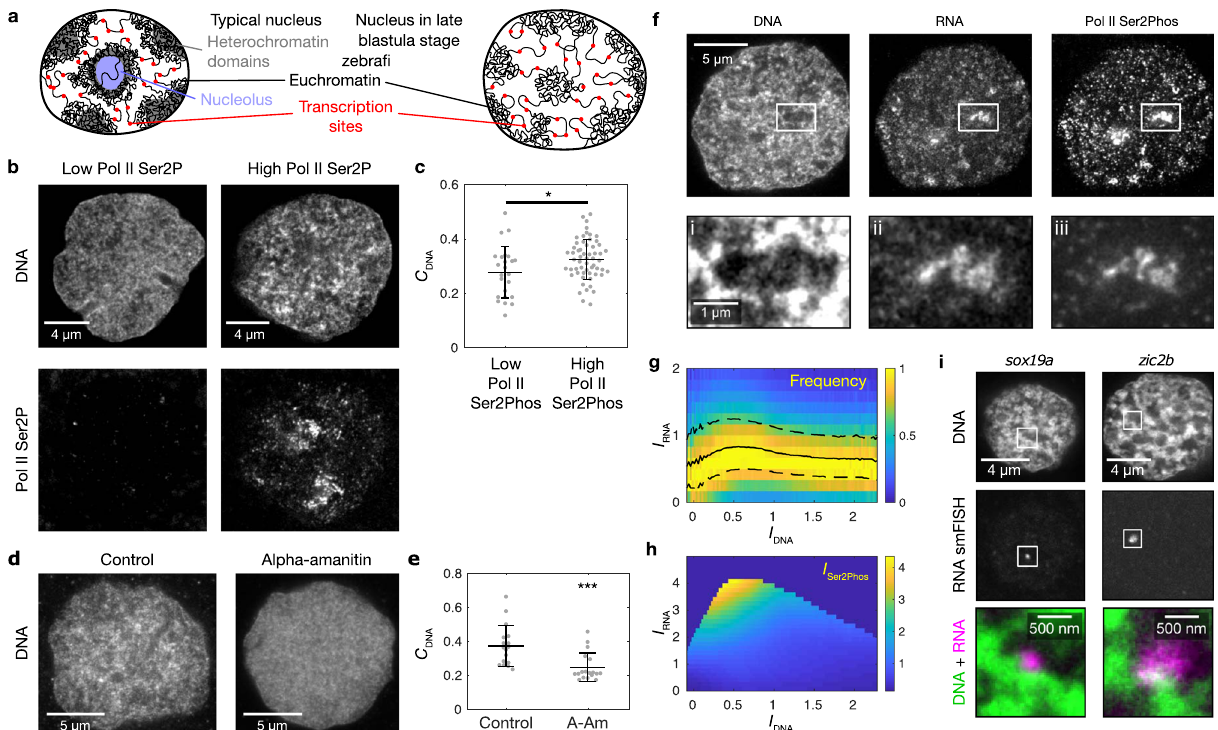
Fig. 1 Transcription onset after mitosis establishes transcription pockets and euchromatin domains. a Sketch of nuclear compartmentalization in a typical nucleus and in the nucleus of a late blastula (sphere) stage zebra fi sh embryo. b Representative mid-sections of nuclei after mitosis and before transcription onset (Low Pol II Ser2Phos), and after transcription onset (High Pol II Ser2Phos). The same results were obtained in four independent experiments. c DNA image contrast ( C DNA ) for low and high Pol II Ser2Phos nuclei. Mean ± SD, * indicates P < 0.05 ( P value 0.02 from a two-sided permutation test, n = 24,58 nuclei, from fi ve different samples). d Representative nuclear mid-sections for control and α -amanitin treatment. The same results were obtained in two independent experiments. e C DNA for control and α -amanitin (A-Am) treatment. Mean ± SD, *** indicates P < 0.001 ( P value 0.00007 from a two-sided permutation test, n = 17,18 nuclei, from two different samples per condition). f Representative three-color micrographs showing DNA, RNA, and transcriptional activity (Pol II Ser2Phos) in a nuclear mid-section after transcription onset. The same results were obtained in four independent experiments. g 2D histogram displaying the frequency of observing a pixel with a speci fi c RNA fl uorescence intensity ( I RNA ) together with a given DNA intensity ( I DNA ). Solid and dashed lines are median and 25th and 75th percentile, respectively. n = 60 nuclei after transcription onset were used for analysis. h 3D pseudo-surface plot displaying the mean Pol II Ser2Phos intensity ( I Ser2Phos ) observed for a given I RNA and I DNA . Same nuclei as in panel g were used for analysis. i Representative nuclear mid-sections showing RNA smFISH detection of transcription sites of the zygotic transcripts sox19a and zic2b . The same results were obtained in two independent experiments. All microscopy images in this fi gure were acquired by STED super-resolution